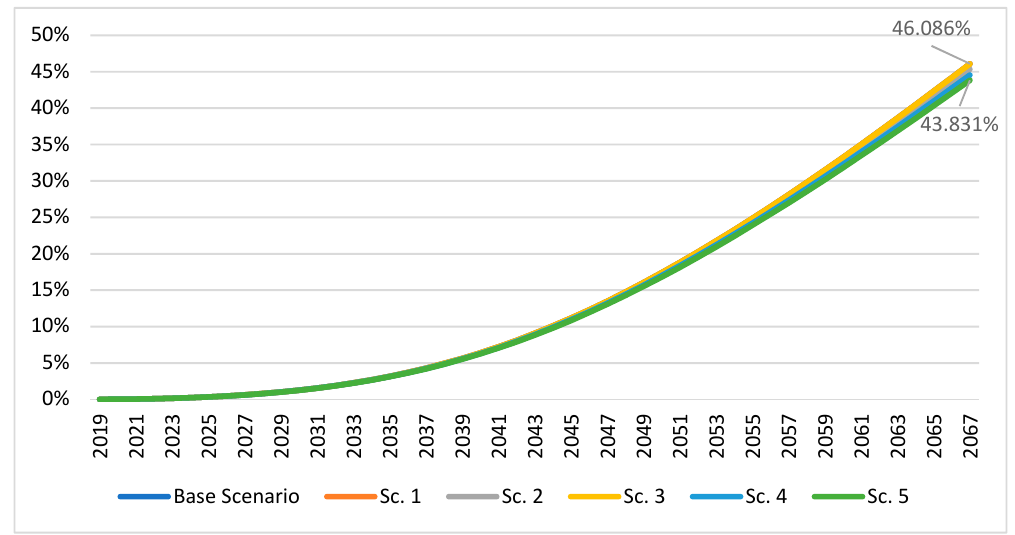
Figure 10. Cumulative savings since 2019/GDP 2019 by applying the SF. Various scenarios. Source: Own elaboration.